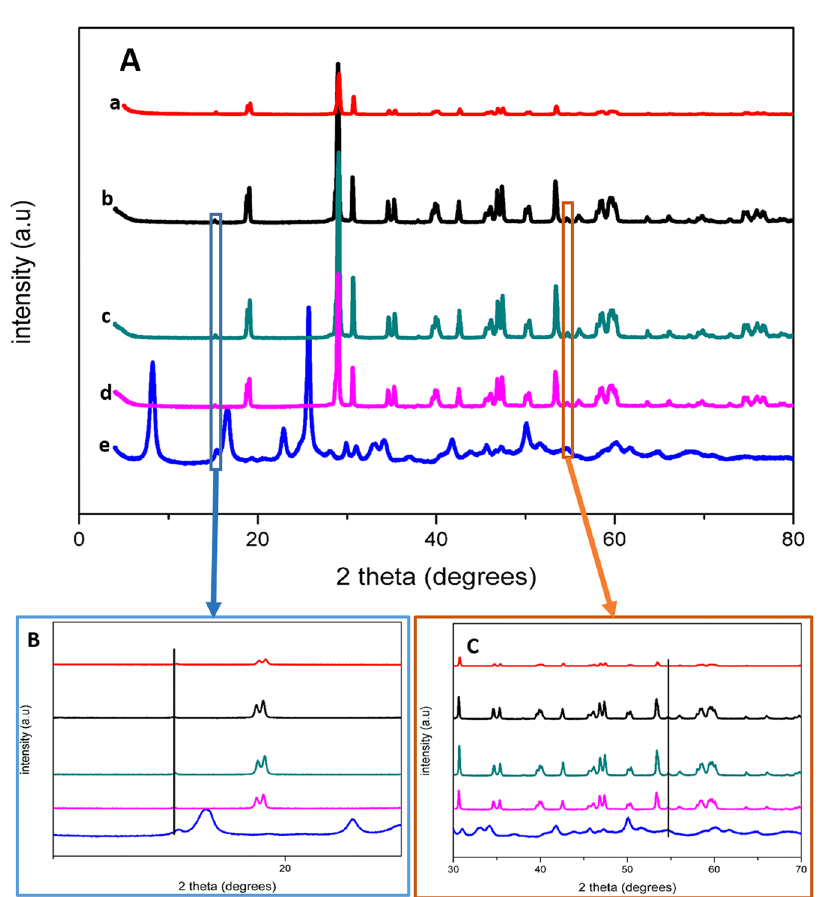
Figure 4. ( A ) XRD patterns of (a) BiVO 4 , (b) 1–1 Bi:Ti, (c) 3–2 Bi:Ti, (d) 2–3 Bi:Ti and (e) MIL-125(Ti). ( B , C ) are zoomed in images showing MIL-125(Ti) patterns in the